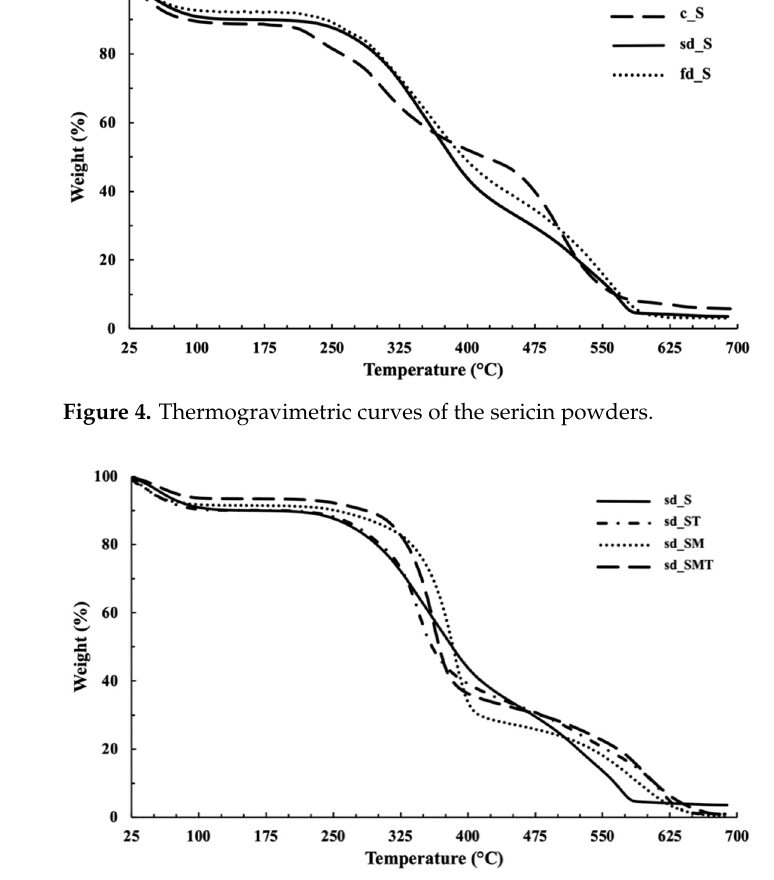
Figure 4. Thermogravimetric curves of the sericin powders.